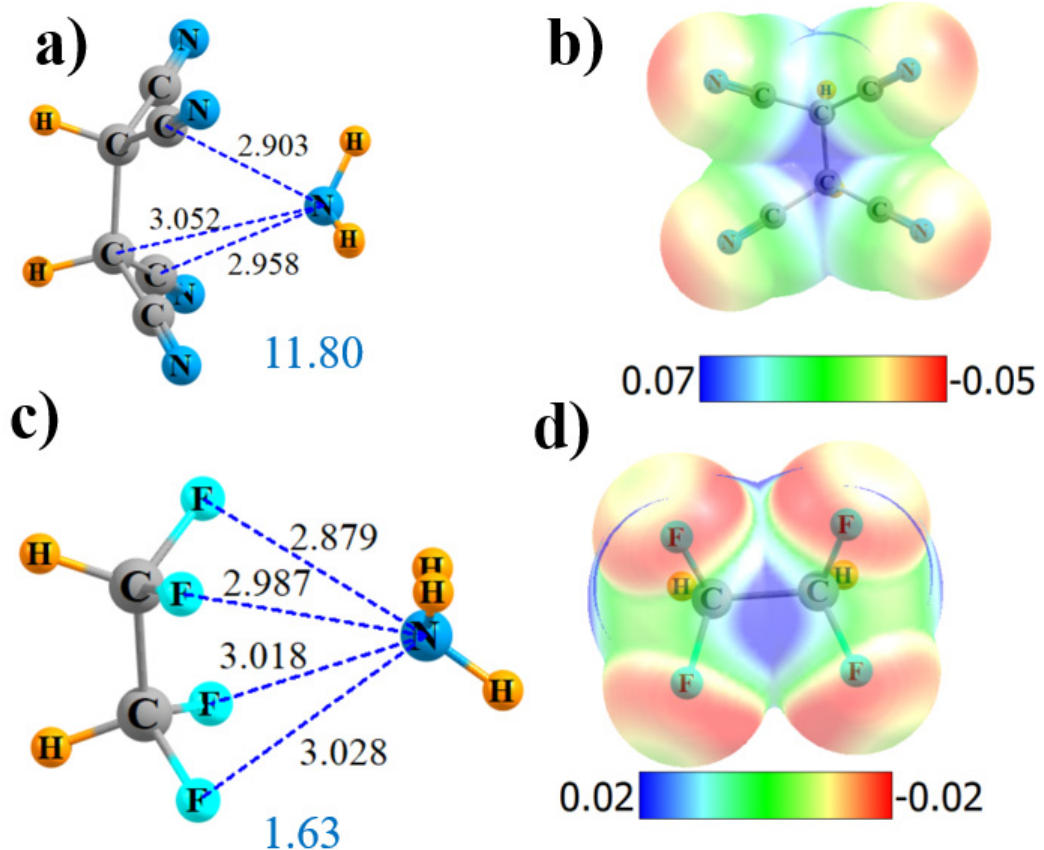
Figure 2. Geometries and monomer MEP of complex of NH 3 with (CN) 2 HC-CH(CN) 2 ( a , b ) and F 2 HC-CHF 2 ( c , d ).